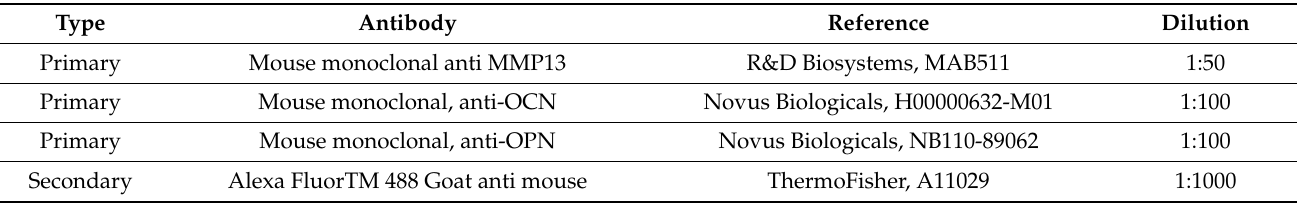
Table 2. Antibodies used for